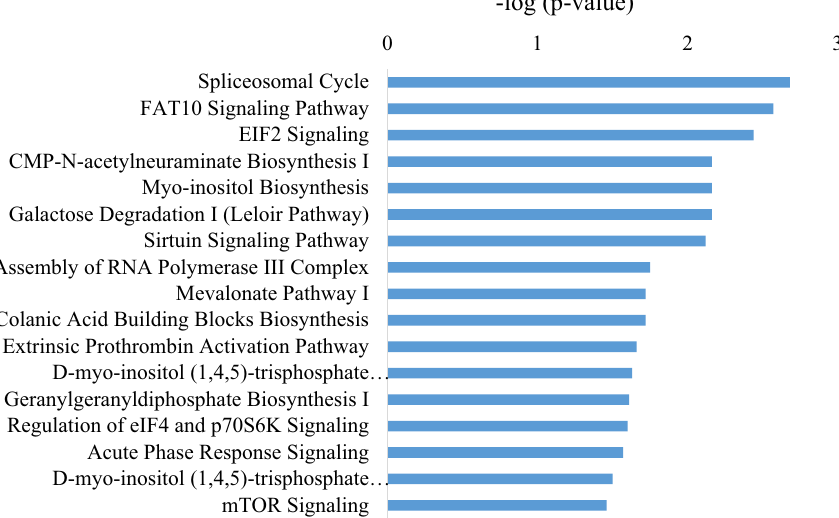
Downregulated/Upregulated proteins in canonical pathways related to feed efficiency Fold change P -value Splicing factor 3a subunit 1 (SF3A1) − 3.85 Splicing factor 3b subunit 2 (SF3B2) DnaJ heat shock protein family (Hsp40) member B11 (DNAJB11) Eukaryotic translation initiation factor 4A1 (EIF4A1)